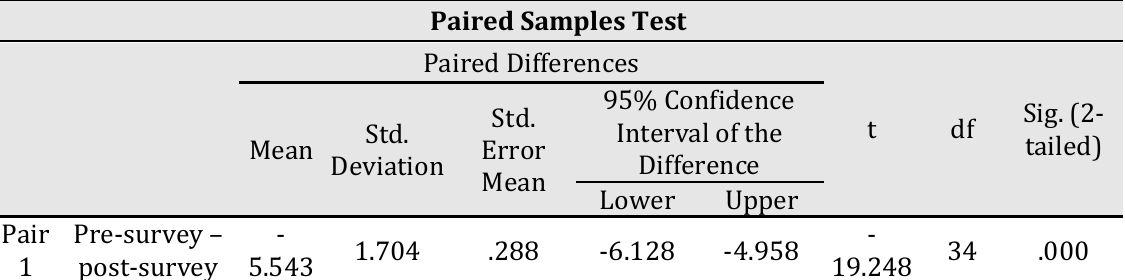
Table 22. probability Value of T-Test of Pre-survey and